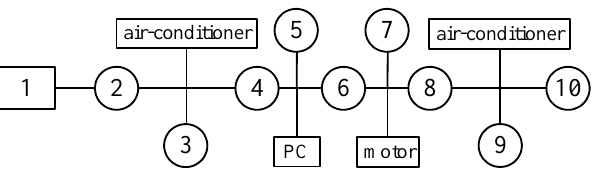
Figure 16. Topology of the test-bed.